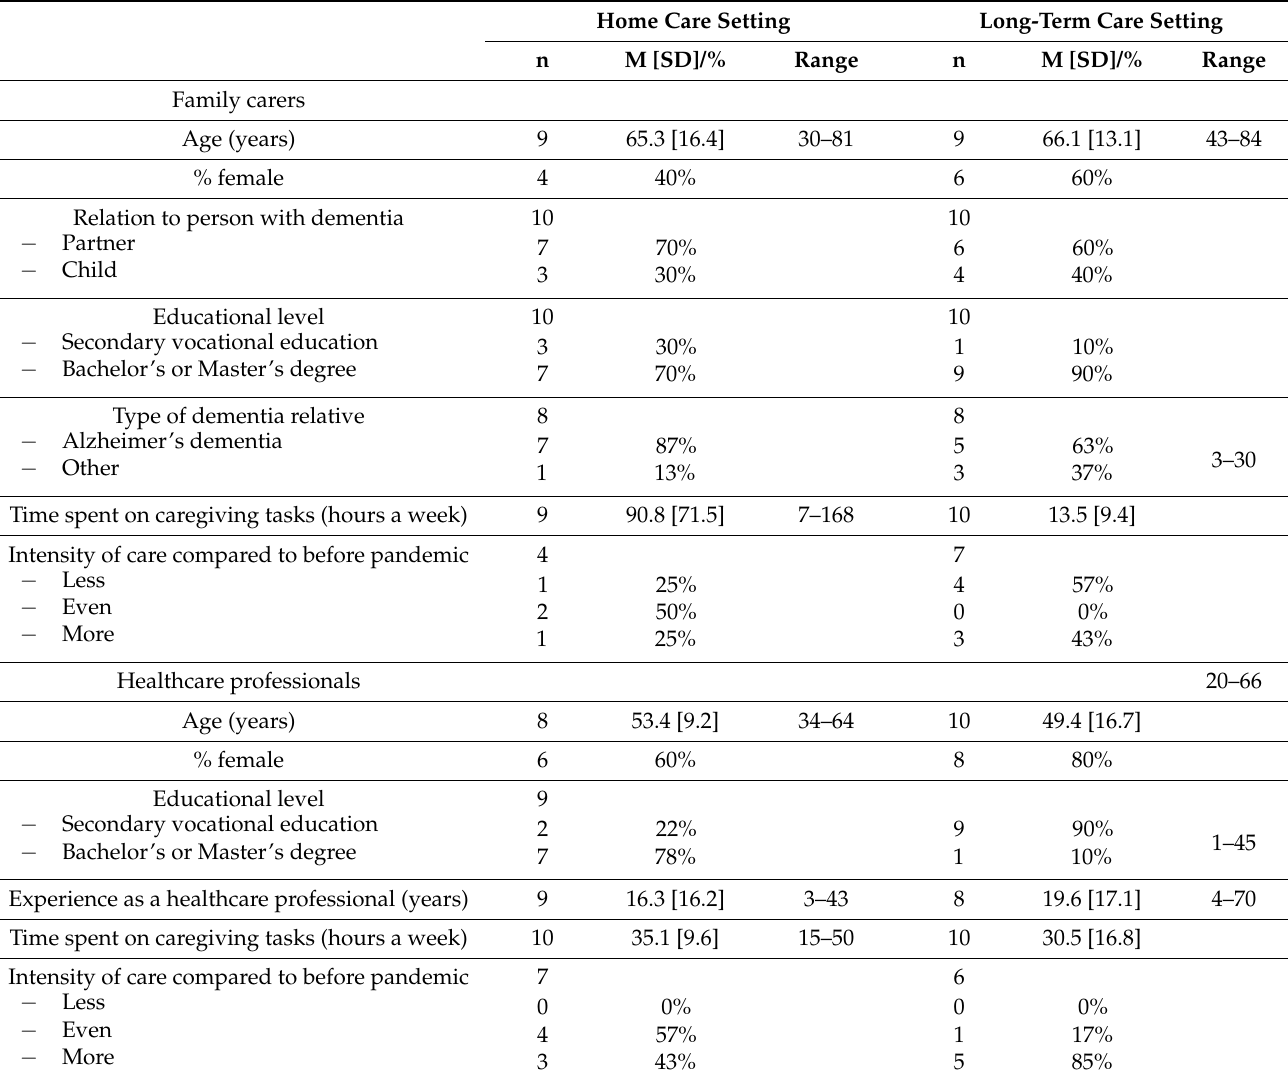
Table 1. Sample characteristics per